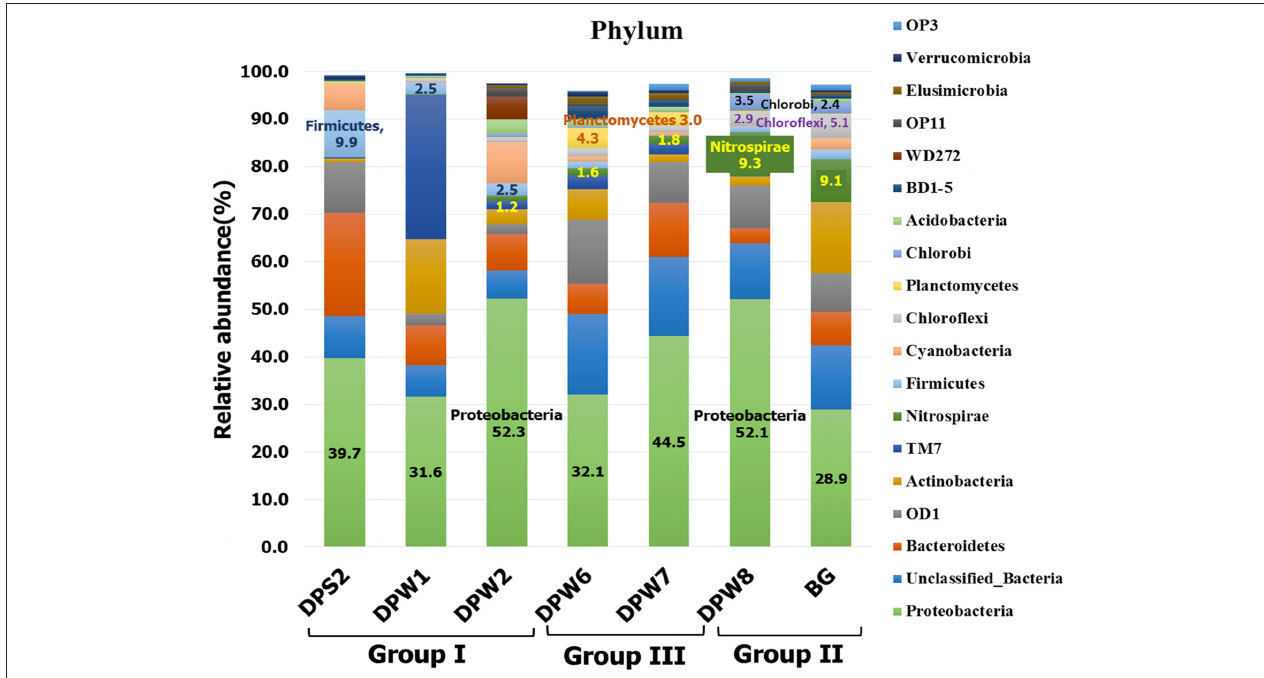
FIGURE 4 | Comparison of the dominant bacterial taxa at the phylum level. The dominant microbes at the phylum level are defined as the taxa had relative abundances of the average value of all groundwater samples > 0.5%.